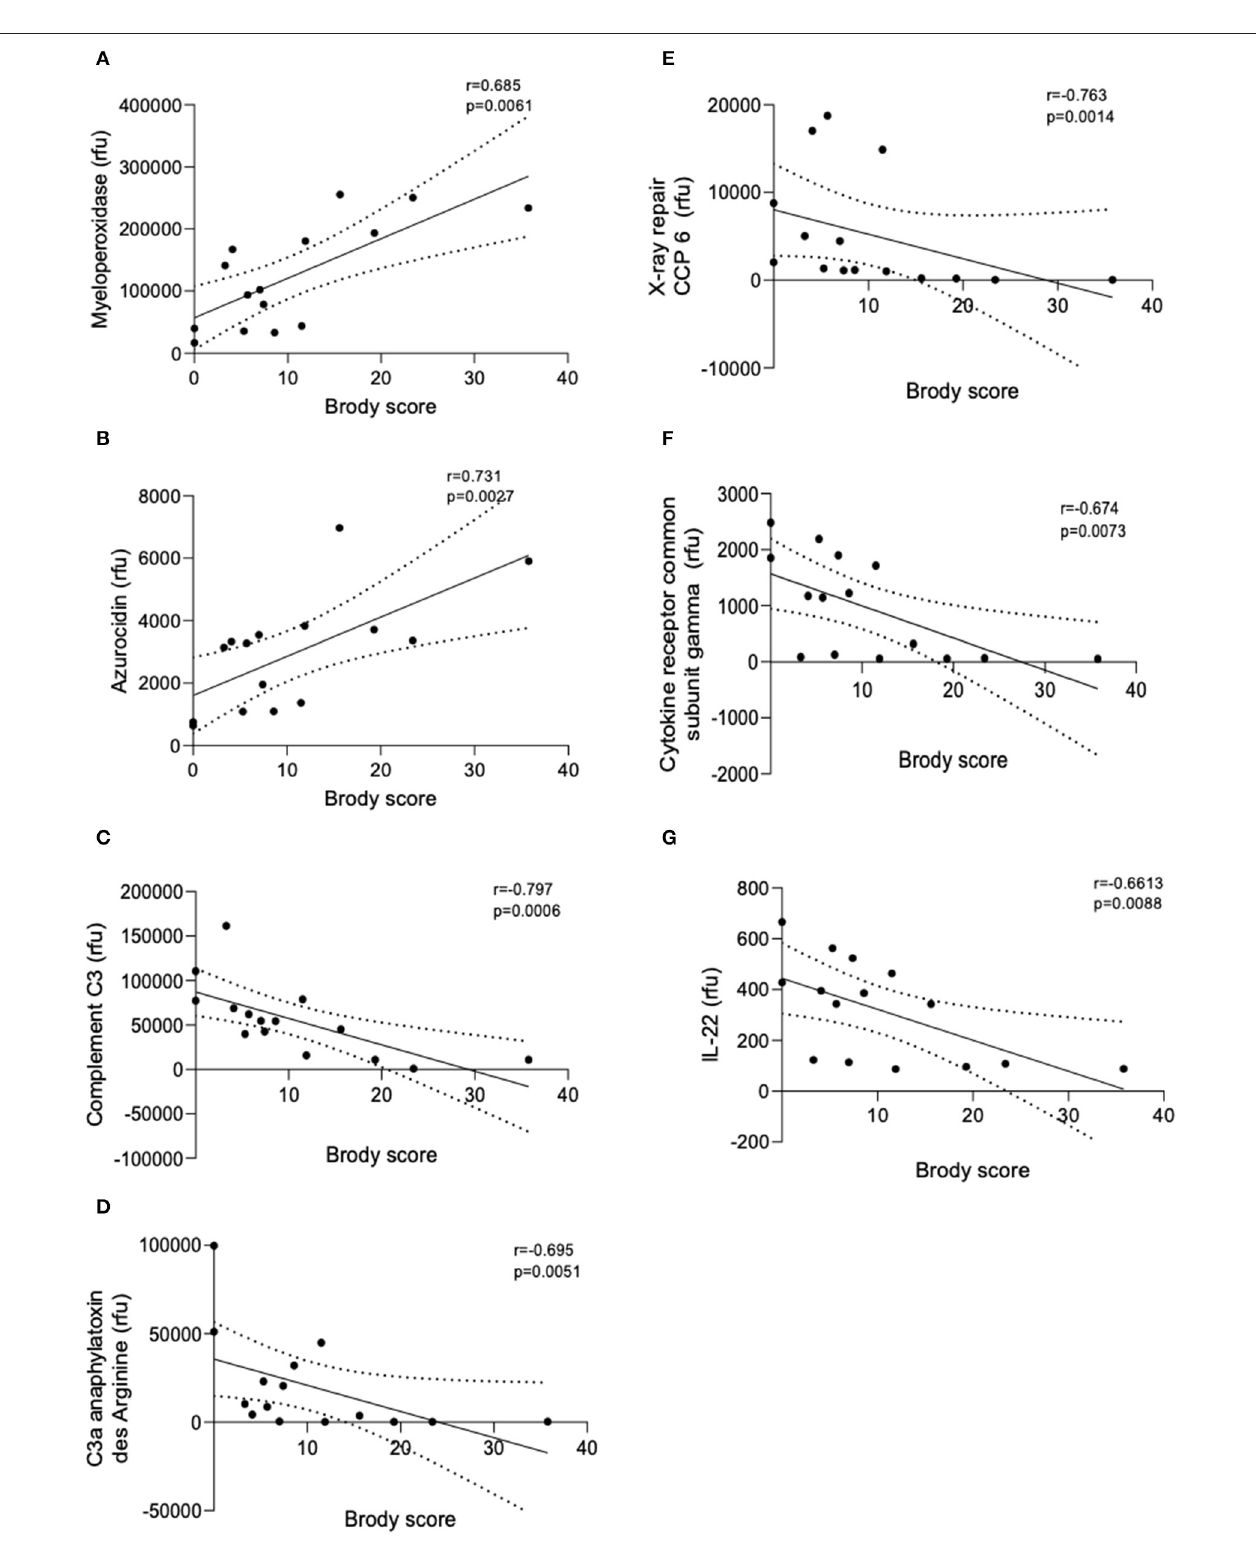
FIGURE 1 | Linear regression models of BAL protein concentrations correlated with Brody score. Linear regression analysis of the relative fluorescent units (rfu) of the seven proteins that correlated with Brody scores. (A) Myeloperoxidase, (B) Azurocidin, (C) Complement C3, (D) C3a anaphylatoxin des Arginine, (E) X-ray repair CCP-6, (F) Cytokine receptor common subunit gamma, and (G) IL-22. Spearman’s Rho = r. Coefficient of determination = R 2 . Dashed lines represent 95% confidence intervals.